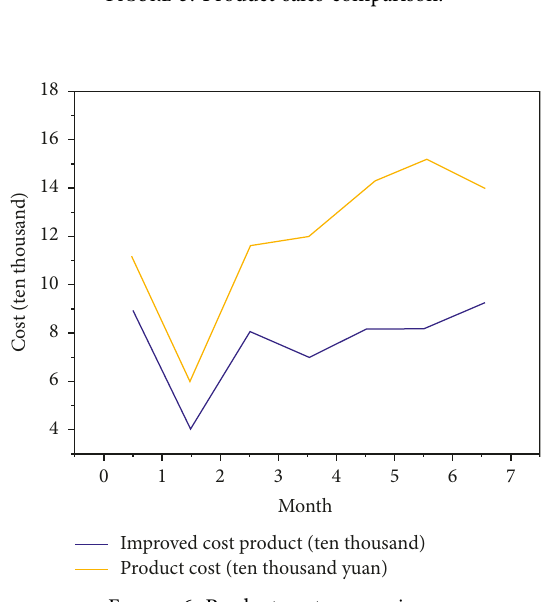
Figure 5: Product sales